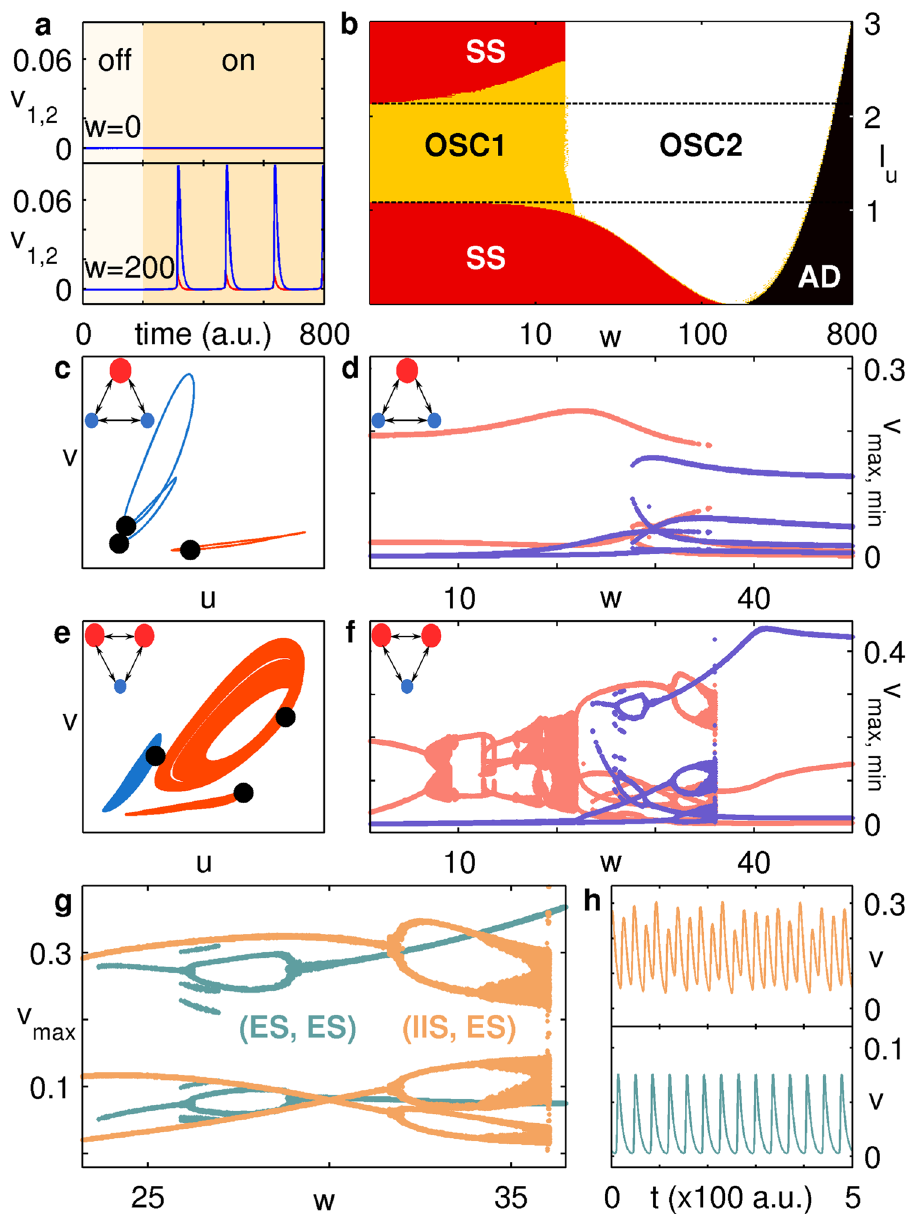
Figure 2. ( a,b ) Coupling-induced oscillations in a pair of nodes, where only one receives a stimulus I u (i.e., N = 2, N stim = 1). ( a ) By switching “on” a stimulus that is too weak ( I u = 0.1) to generate activity in the uncoupled nodes (top), oscillations can be observed by strongly coupling the stimulated (red) and unstimulated (blue) nodes (bottom). In the “off” state, the nodes receive no external input (i.e., I u = 0). ( b ) The range of I u for which oscillations emerge increases at higher w , with the region within the broken lines indicating the range of I u for which oscillations are observed in an isolated node. The amplitude of the oscillations is larger for the stimulated node at low w (OSC1) and for the unstimulated node at high w (OSC2). The other dynamical regimes observed correspond to a non-zero steady state (SS) and a quiescent state characterizing amplitude death (AD). The regimes are determined via order parameters and identified as the pattern obtained from the majority ( > 50%) of random initial states (see Supporting Information). ( c–h ) Symmetry breaking in a system of N = 3 globally coupled nodes for input stimulus I u = 1.25. The stimulated (large, red) and unstimulated (small, blue) nodes are indicated schematically in top-left corner of ( c–f ). Phase space projections of the trajectories (colored as per the schematic) are shown for ( c ) N stim = 1, displaying (ES, IIS) state for w = 38 (note the broken symmetry in unstimulated nodes) and ( e ) N stim = 2, exhibiting chaos for w = 35.6. In the corresponding bifurcation diagrams for ( d ) N stim = 1 and ( f ) N stim = 2, the peaks and troughs of the inhibitory component ( v m ax , min ) are shown as a function of w for the stimulated (pink) and unstimulated (violet) nodes. ( g ) Magnified view of ( f ) showing the coexistence of qualitatively distinct dynamical attractors corresponding to (IIS, ES) [orange] and (ES, ES) [green]. The system can exhibit either chaotic or non-chaotic behavior depending on its initial state, as illustrated in the top and bottom panels of ( h ) for w =